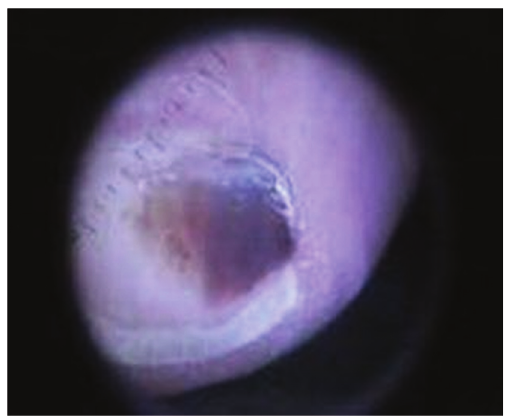
Figure 4: Dermoscopy before 3mm biopsy.